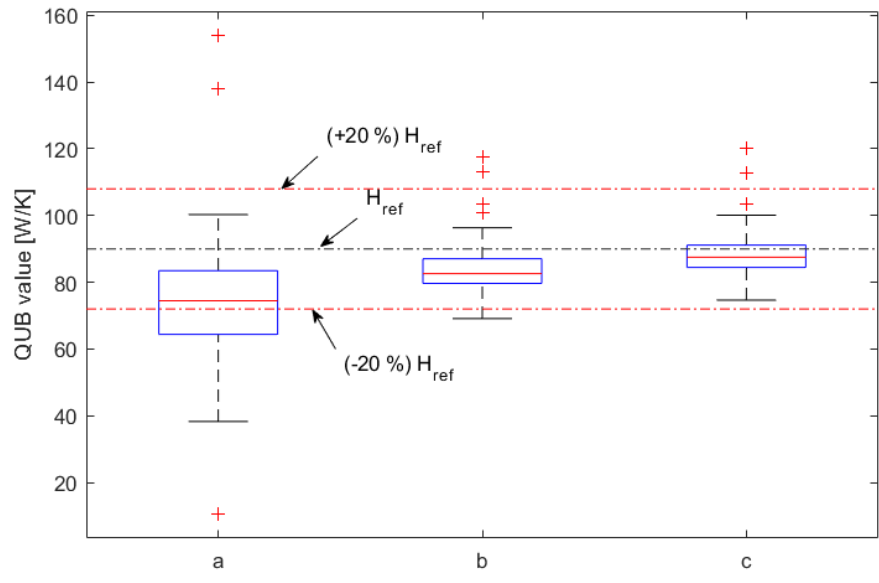
Figure 10. QUB experiments when simulated at ( a ) 20 ◦ C setpoint temperature and α = 0.5 ( n = 2 ), ( b ) 25 ◦ C setpoint temperature and α = 0.5 ( n = 2) ( c ) 25 ◦ C setpoint temperature and α = 0.67 ( n = 3) .